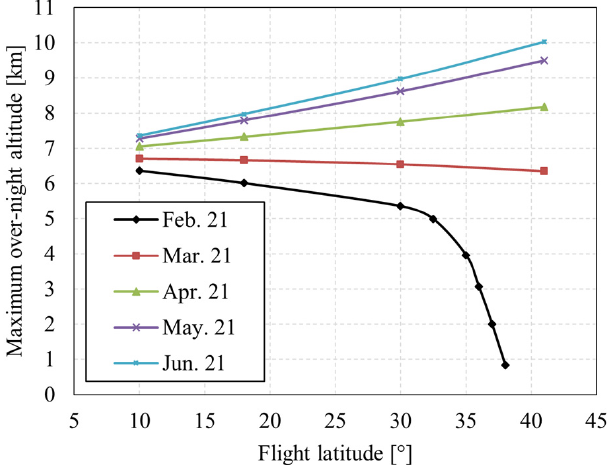
Figure 29. Influence of flight latitude on maximum overnight altitude.